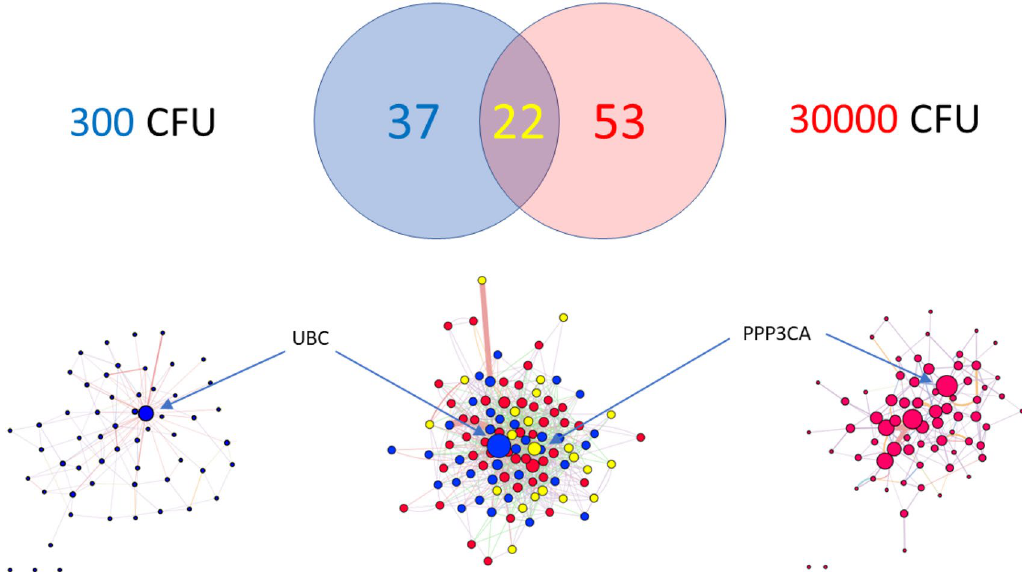
Figure 6. Top: Venn diagram of DEG in 300 and 30,000 CFU experiments. Bottom: Networks of DEG for 300 CFU (left), 30,000 CFU (right) experiments. Network of both sets of DEG is shown in bottom, center. Network nodes colored blue, red, and yellow denote genes in 300, 30,000, and both 300 and 30,000 DEG gene sets, respectively. The sizes of the nodes are scaled to the calculated parameter “stress”; therefore, larger nodes are more connected to other nodes in the network.